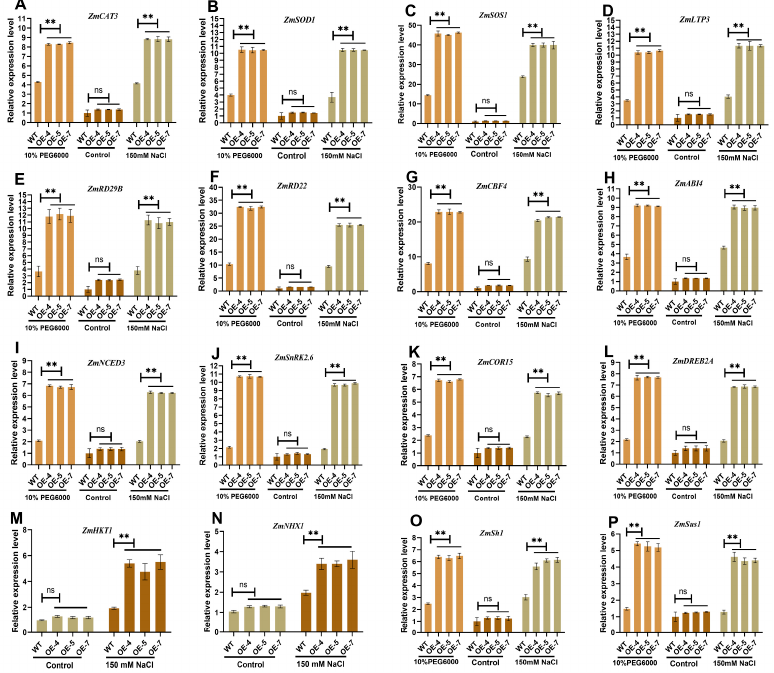
Figure 6. Related gene expression situation. ( A – H ) expression analysis of ROS pathway related genes. ( I – L ) expression of genes related to ABA pathway. ( M , N ) expression analysis of sodium ion transporter gene. ( O , P ) expression analysis of sugar synthase related genes. Values are mean ± SD of three biological replicates. Bars with different letters are significantly different at p < 0.05 according to Duncan’s multiple range tests. Non-significance (ns), p < 0.05 (**).